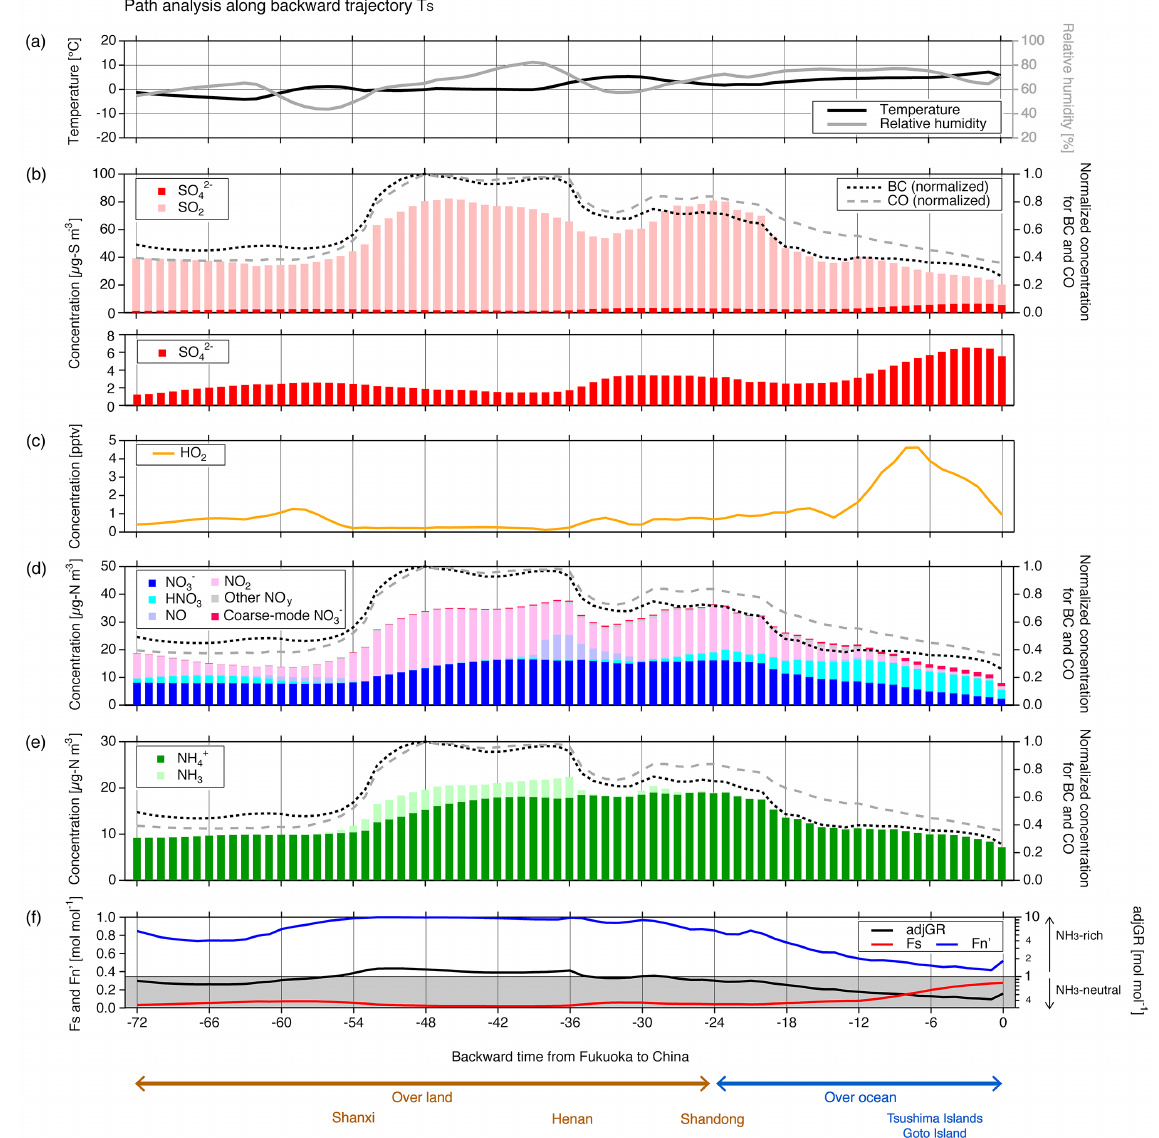
Figure 12. The path analysis of the model results along trajectory T S . (a) Temperature and relative humidity; (b) SO 2 − the bottom) and SO 2 ; (c) HO 2 concentration; (d) NO − , HNO 3 , NO, NO 2 , other NO y (NO 3 , HNO 2 , N 2 O 5 , and PANs), and coarse-mode 3 NO − ; (e) NH + and NH 3 ; (f) adjGR, F s , and F (cid:48) n . In (b) , (d) , and (e) , BC and CO concentrations normalized to the maximum value are also 3 4 shown. The time axis indicates the backward time from Fukuoka. The brown and blue bars at the bottom are schematics of the trajectory location over land and